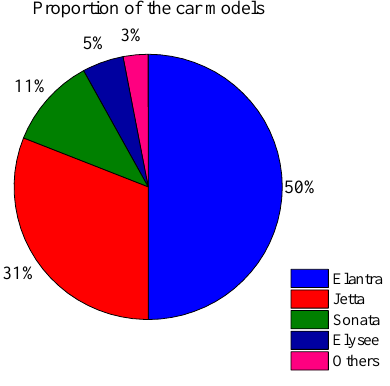
Figure 1. Proportion of different car models of the current taxi in Beijing.